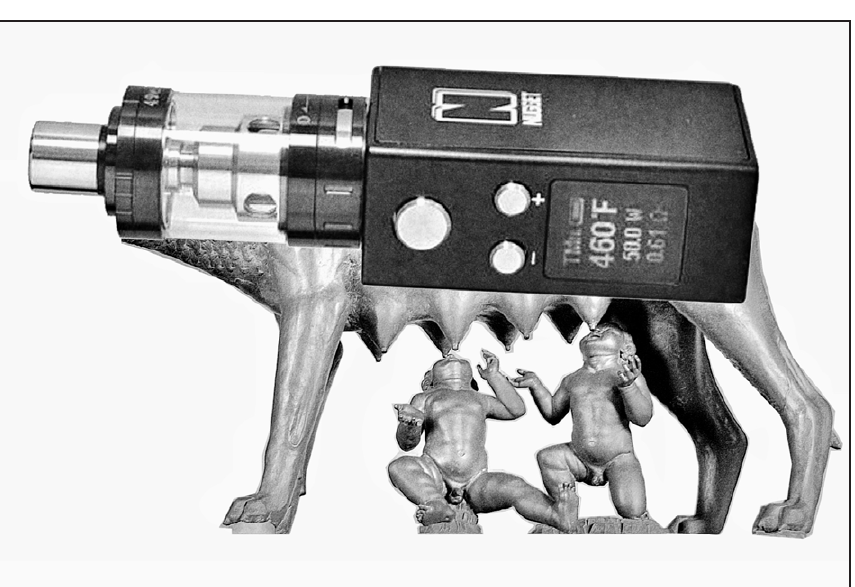
Figure 2: We wished to critique the insidious militarization of public health-care and private reproductive